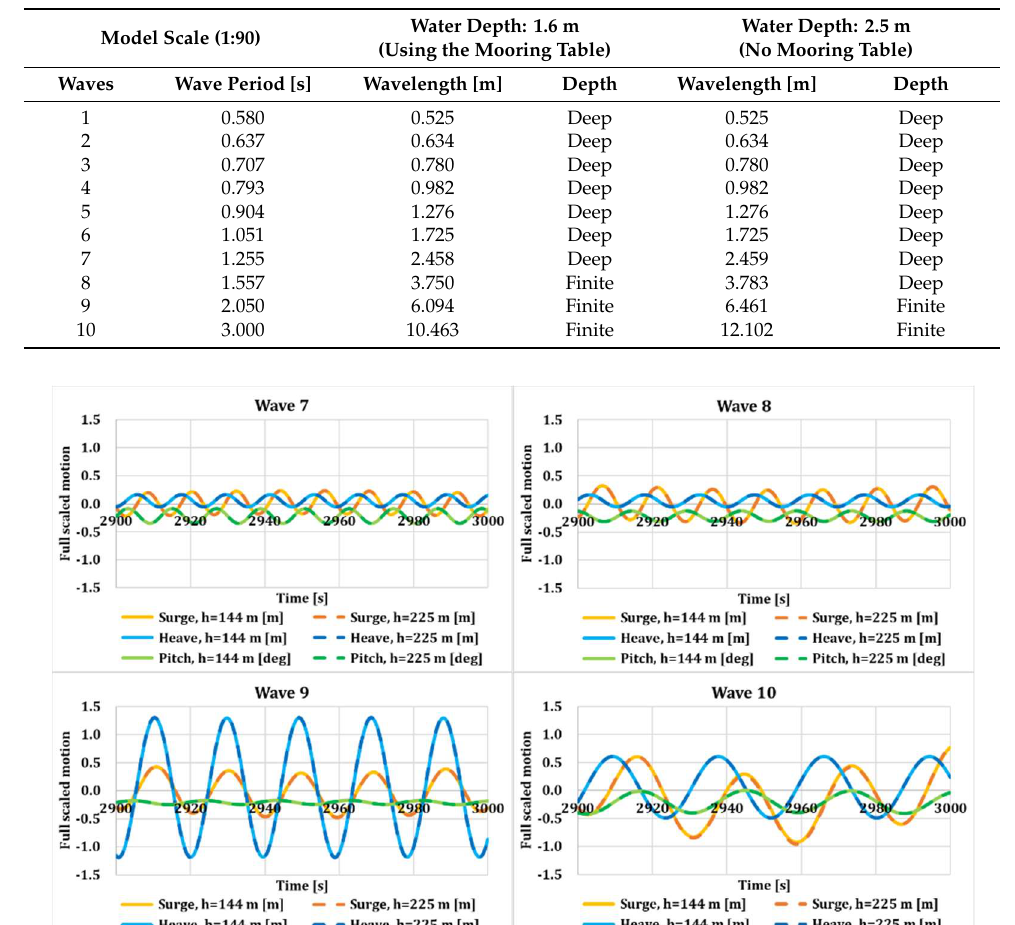
Table 5. Determining the water depths.